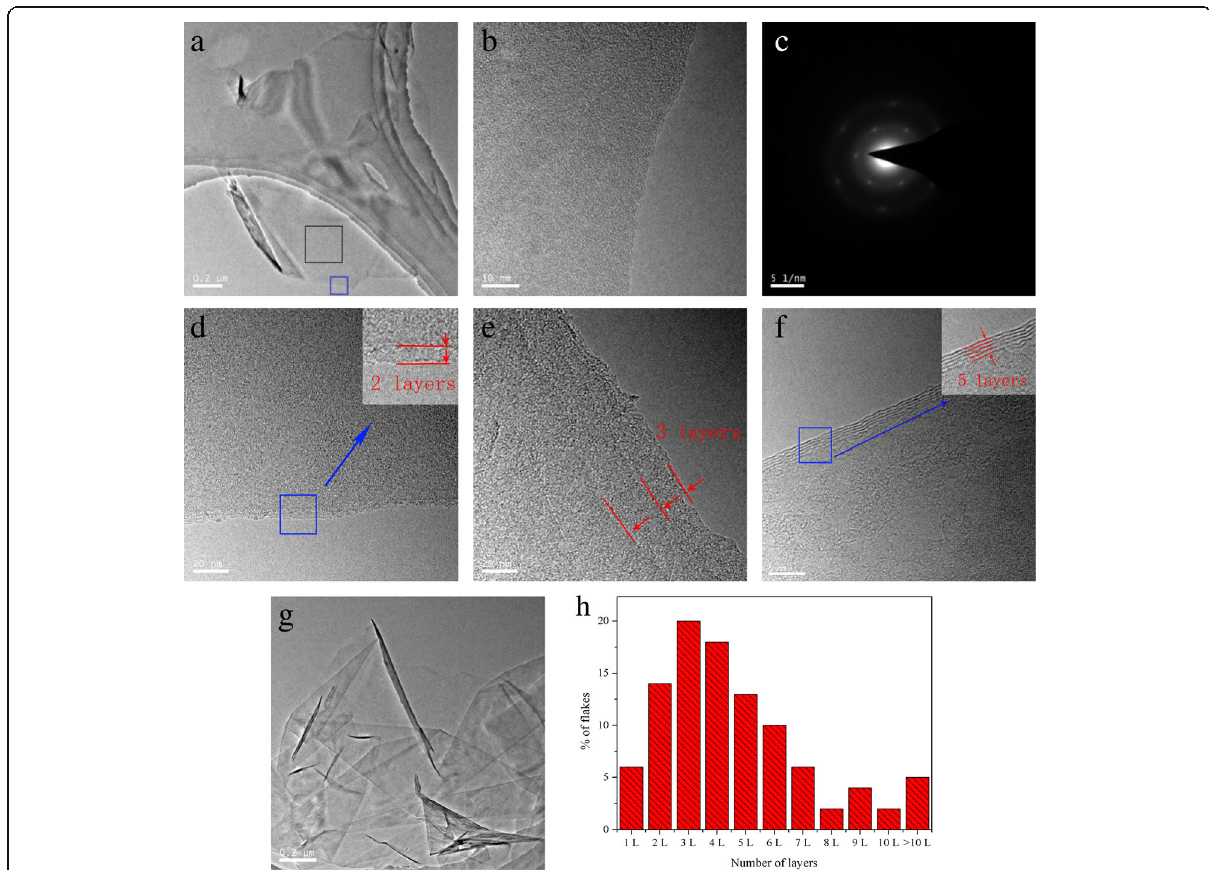
Fig. 4 Typical TEM images and electron diffraction of the prepared graphene flakes. a Mono-layer graphene flake with folded edge, b magnified image of the blue box in image ( a ), c electron diffraction of the selected black box in image ( a ), d a bilayer graphene flake, e a trilayer graphene flake, f a five-layer graphene flake, g several individual graphene flakes, h distribution of number of layers (obtained from TEM analysis of at least 100 graphene